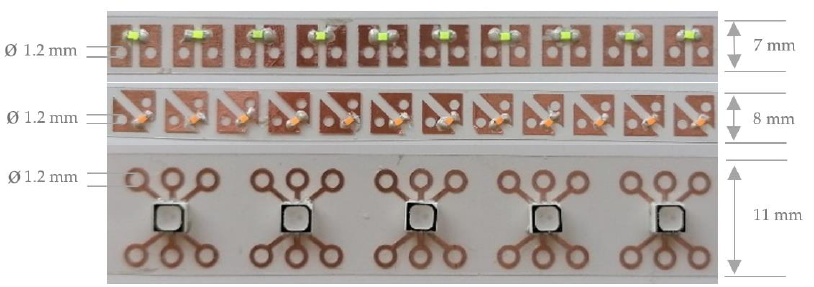
10 of 20 Figure 7. ( a ) Single-layer two-pole LED sequin tape designs and ( b ) multi-pole RGB sequin tape designs. After printing with the wax printer, etching of the unprinted and unreserved copper surfaces and the chemically cleaning of excess adhesive residues follows. All samples are equally very flexible and foldable without cracking the wafer-thin copper layers. The surface on the copper-glued PET film is smooth and the copper sur- faces are hardly noticeable because the layer the layer has a board thickness of just 0.14